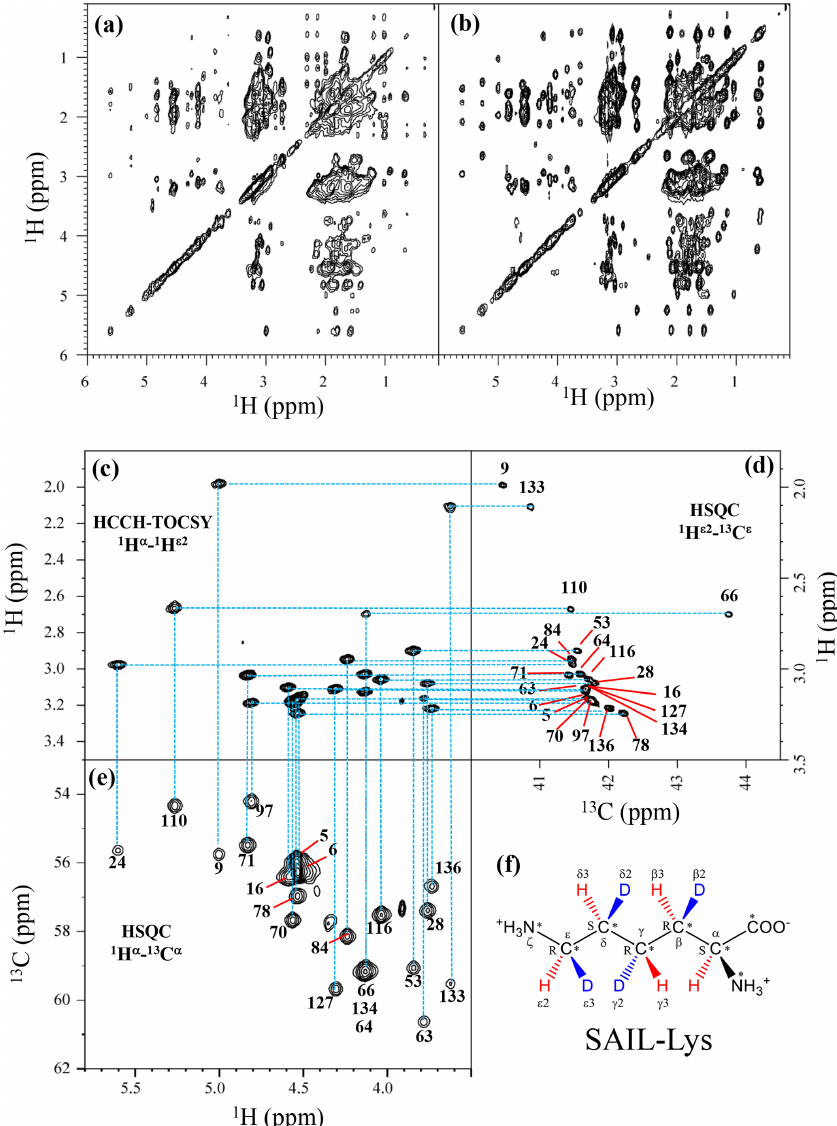
Figure 1. Sequential assignment of the Lys side-chain signals for the SNase variant selectively labeled with SAIL-Lys using the 3D HCCH TOCSY experiment. Panels (a) and (b) show a comparison of the F1–F3 projections of the 3D HCCH TOCSY spectra obtained for the SNase variant selectively labeled with either [U- 13 C, 15 N]-Lys (a) or SAIL-Lys (b) . A complete side-chain signal assignment was established for the SNase variant selectively labeled with SAIL-Lys by the correlation networks on the 3D HCCH TOCSY spectrum, starting from the backbone 1 H α and 13 C α signals with assignments deposited in the BMRB (entry #16123; Chimenti et al., 2011). For example, the 1 H ε 2 – 13 C ε HSQC signals in panel (d) were unambiguously correlated to the backbone 1 H α – 13 C α HSQC signals in panel (e) , through the 1 H α – 1 H ε 2 correlation signals in panel (c) , which represents the F1–F3 projection of the 3D HCCH TOCSY spectrum along the 13 C axis (F2) restricted for the 13 C ε shift range of 40.1–45.5ppm. The structure of SAIL-Lys, [U- 13 C, 15 N; β 2 , γ 2 , δ 2 , ε 3 -D 4 ]-Lys, is shown in panel (f) . The spectrum was measured at 30 ◦ C on a Bruker Avance 600 spectrometer equipped with a TXI cryogenic probe. The chemical shifts for the 1 H and 13 C dimensions are δ TSP